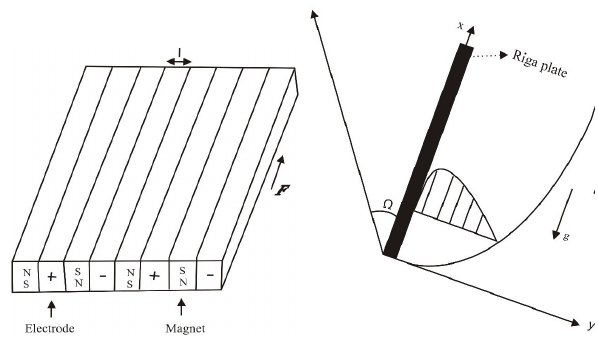
Figure 1: a) Arrangement of electrodes and magnets in the Riga-plate; b) Schematic diagram of the model.